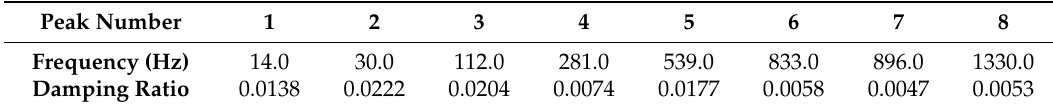
Figure 14. Frequency-domain identification of linear systems.